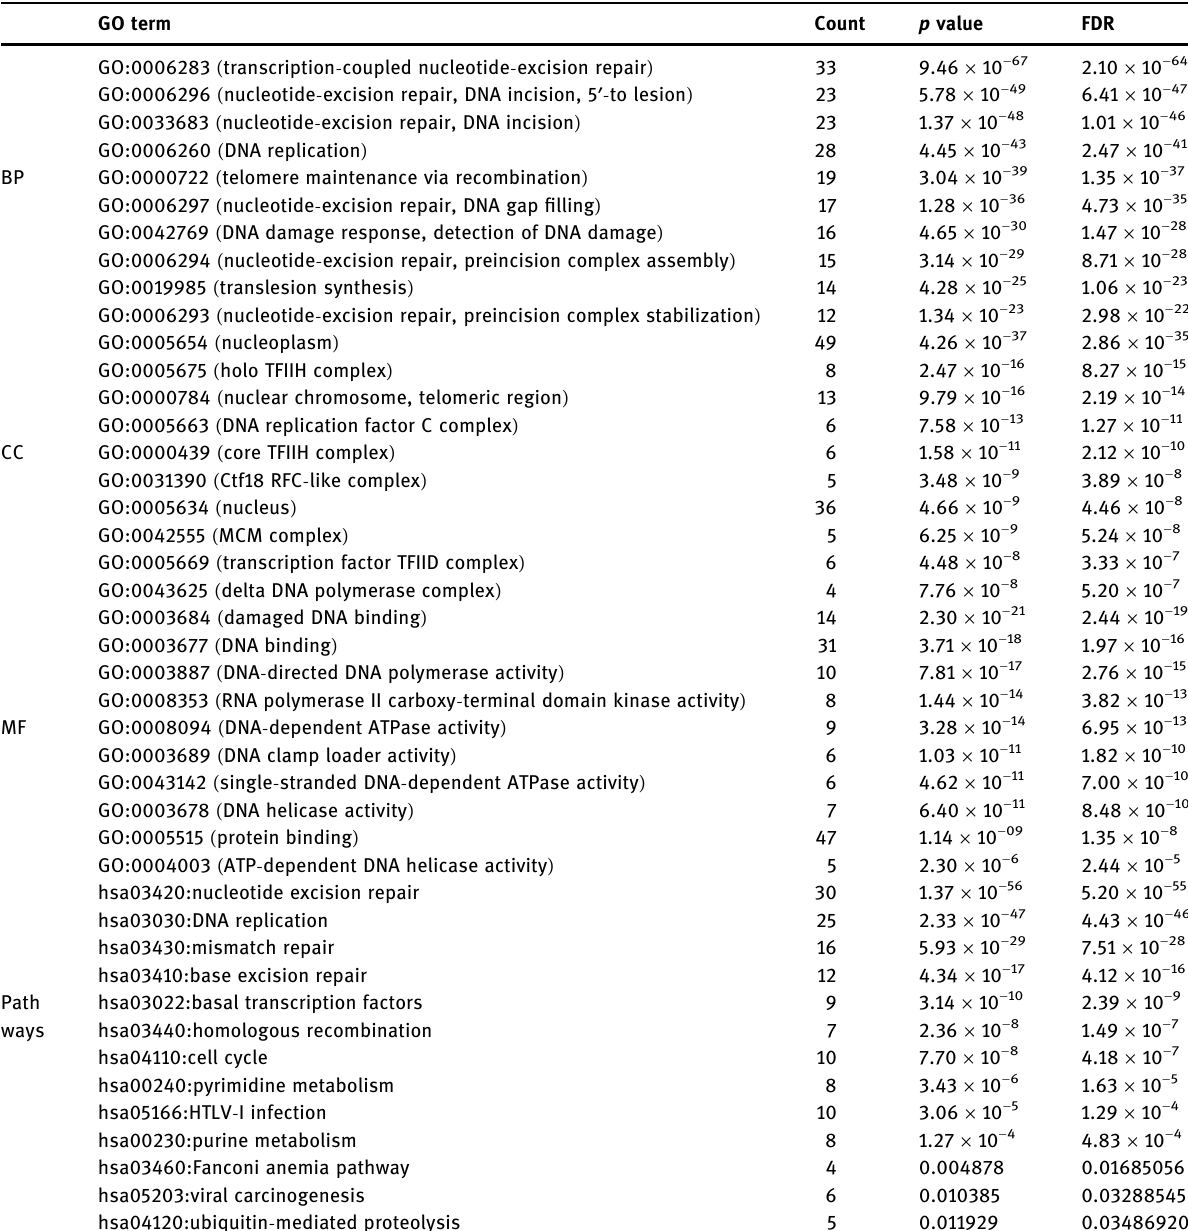
Table 1: Functional annotation enrichment analysis of LIG1 and their interaction genes performed with the DAVID database GO term Count p value